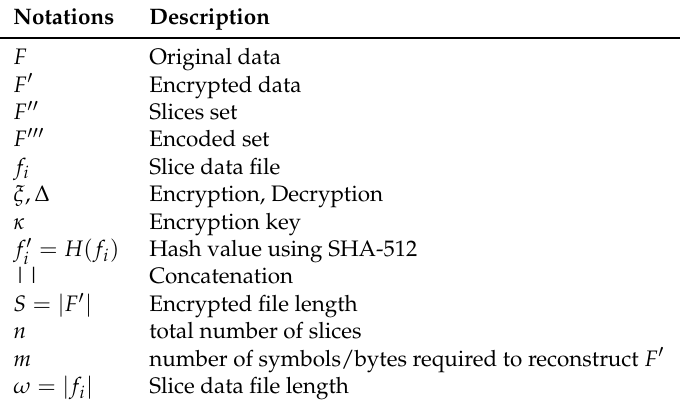
Table 1. Notation and parameter description.